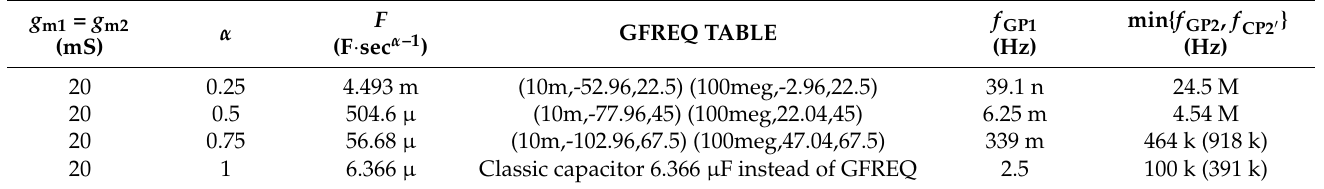
Table 2. The second set of element parameters for simulation of the circuit in Figure 9 and its expected cut-off frequencies. g m1 = g